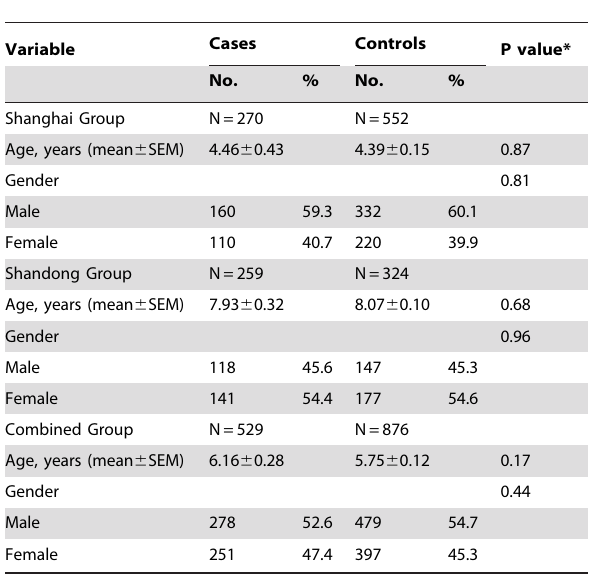
Table 1. Demographic characteristics in CCSDs cases and